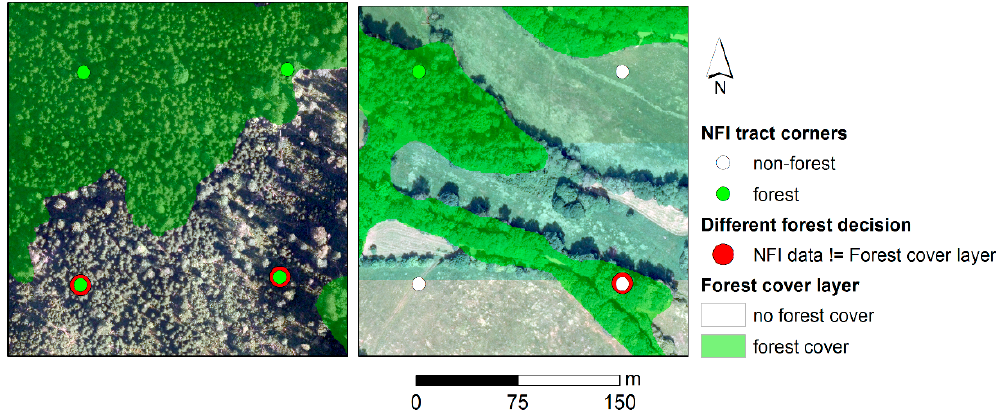
Figure 5. Comparison of NFI forest decision with forest cover map. Differences are outlined in red.